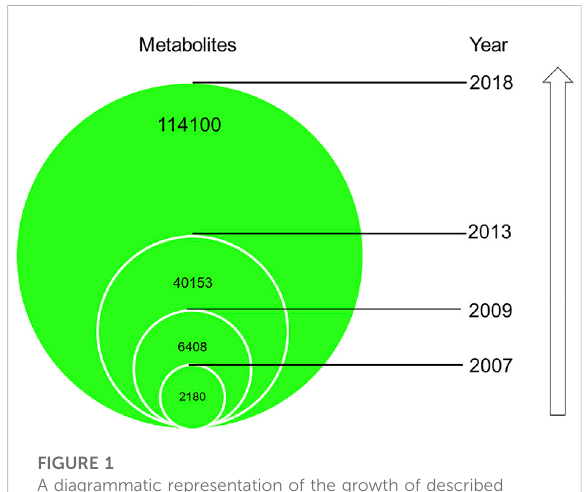
FIGURE 1 A diagrammatic representation of the growth of described metabolites from 2007 in the Human Metabolome Database (HMDB) as reported by Wishart et al.